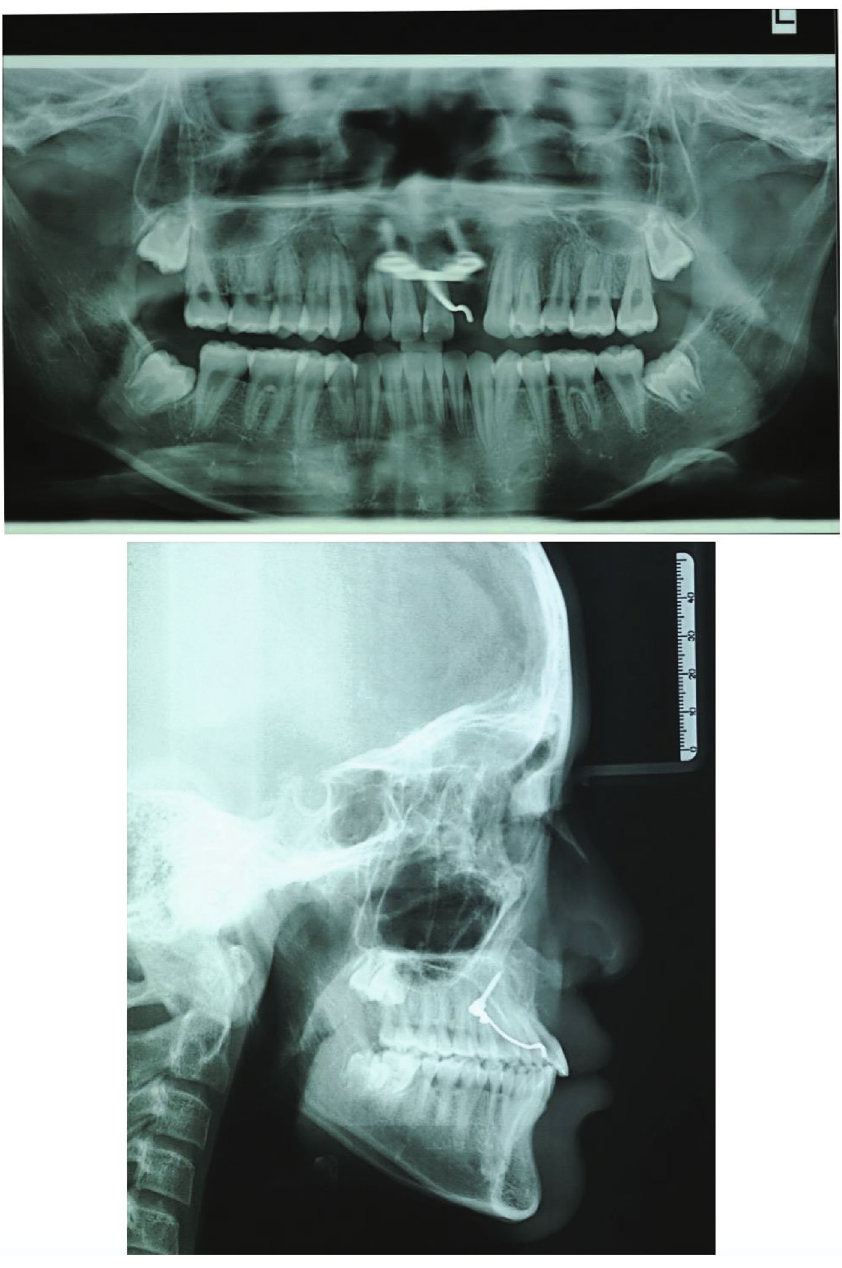
Figure 12: Final panoramic radiograph and lateral cephalogram of the